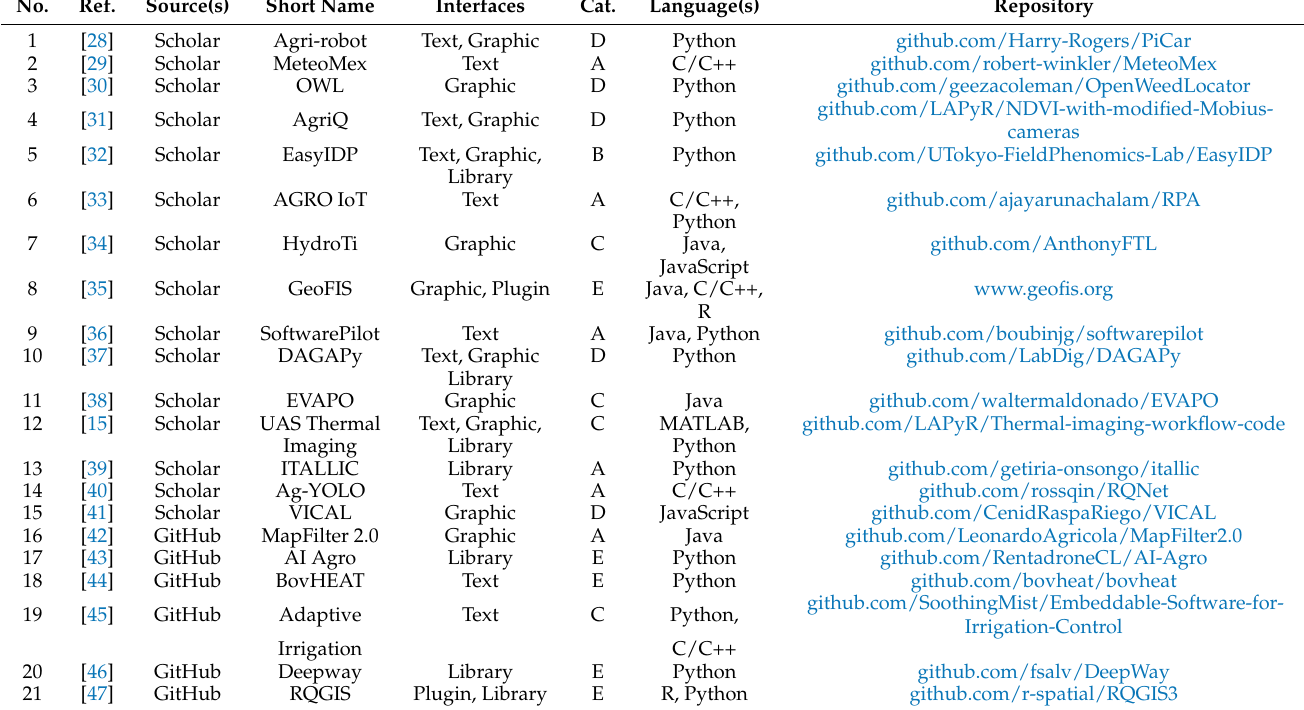
Table 4. Selected works, together with their bibliographic reference, information source, short name, user interface(s), category, programming language(s), and link to source code repository (all links last accessed on 12 March 2023). Categories include: (A) crop and climate protection and diagnosis; (B) nutrition and fertilization of crops; (C) crop irrigation; (D) soil management, planting, growing and harvesting crops; and (E) production management, machinery, and